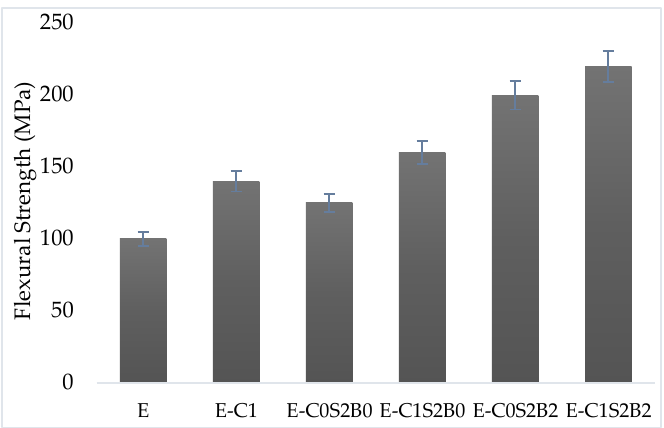
Figure 4. Flexural strength of epoxy, nano and multiscale composites. Table 5. Axial cyclic compression test